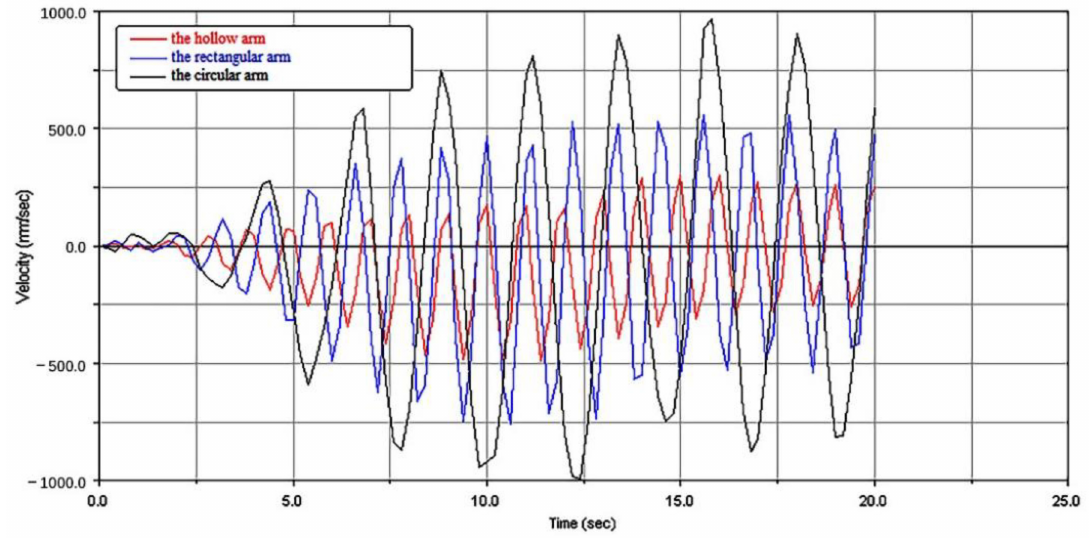
Figure 14. End speed distribution with different arm